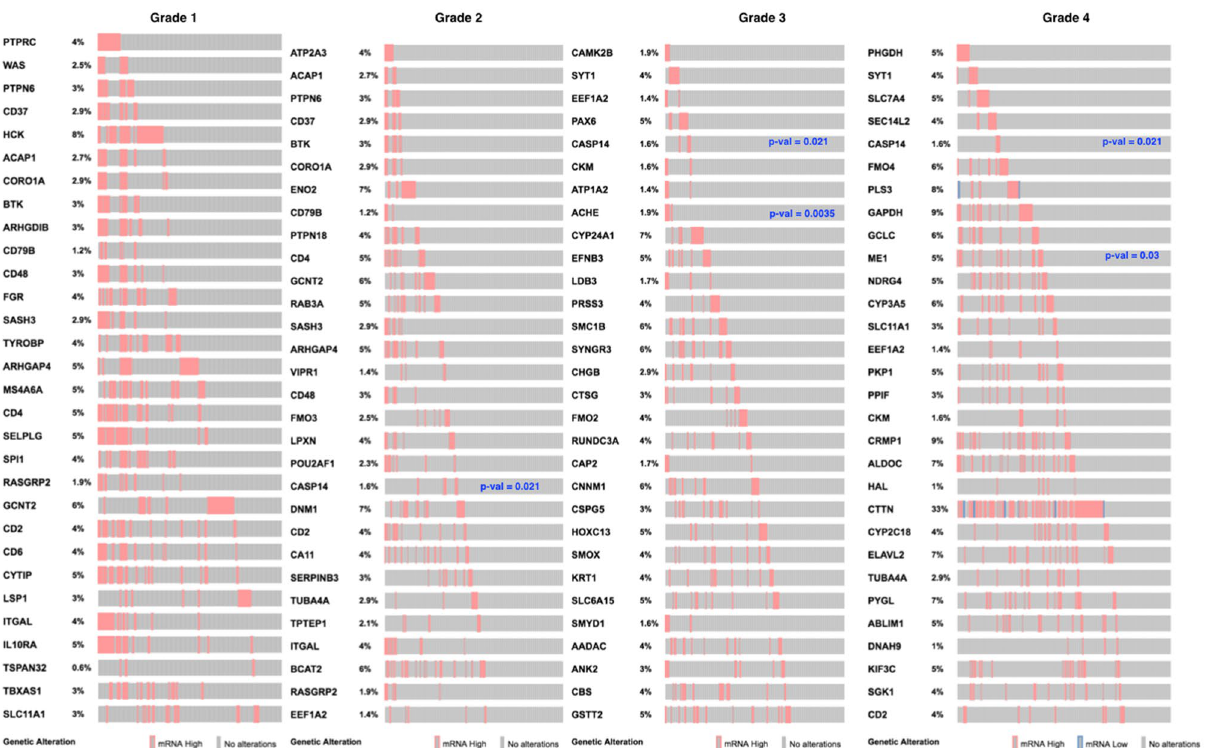
Figure 4. Clinical relevance. Clinical Relevance for the top-ranked genes (based on connectivity of the genes within the network generated through network database) and respective inferred pathways. p-value represents the clinical significance in terms of survival analysis and the TCGA database and cBioPortal have been